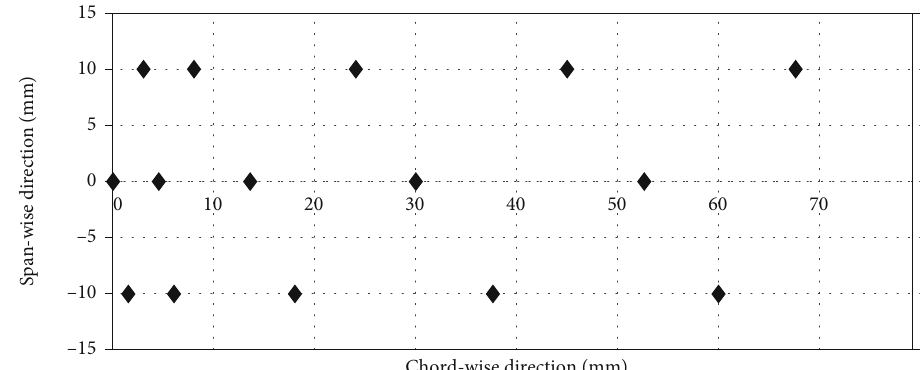
Figure 10: Distribution of pressure taps on model